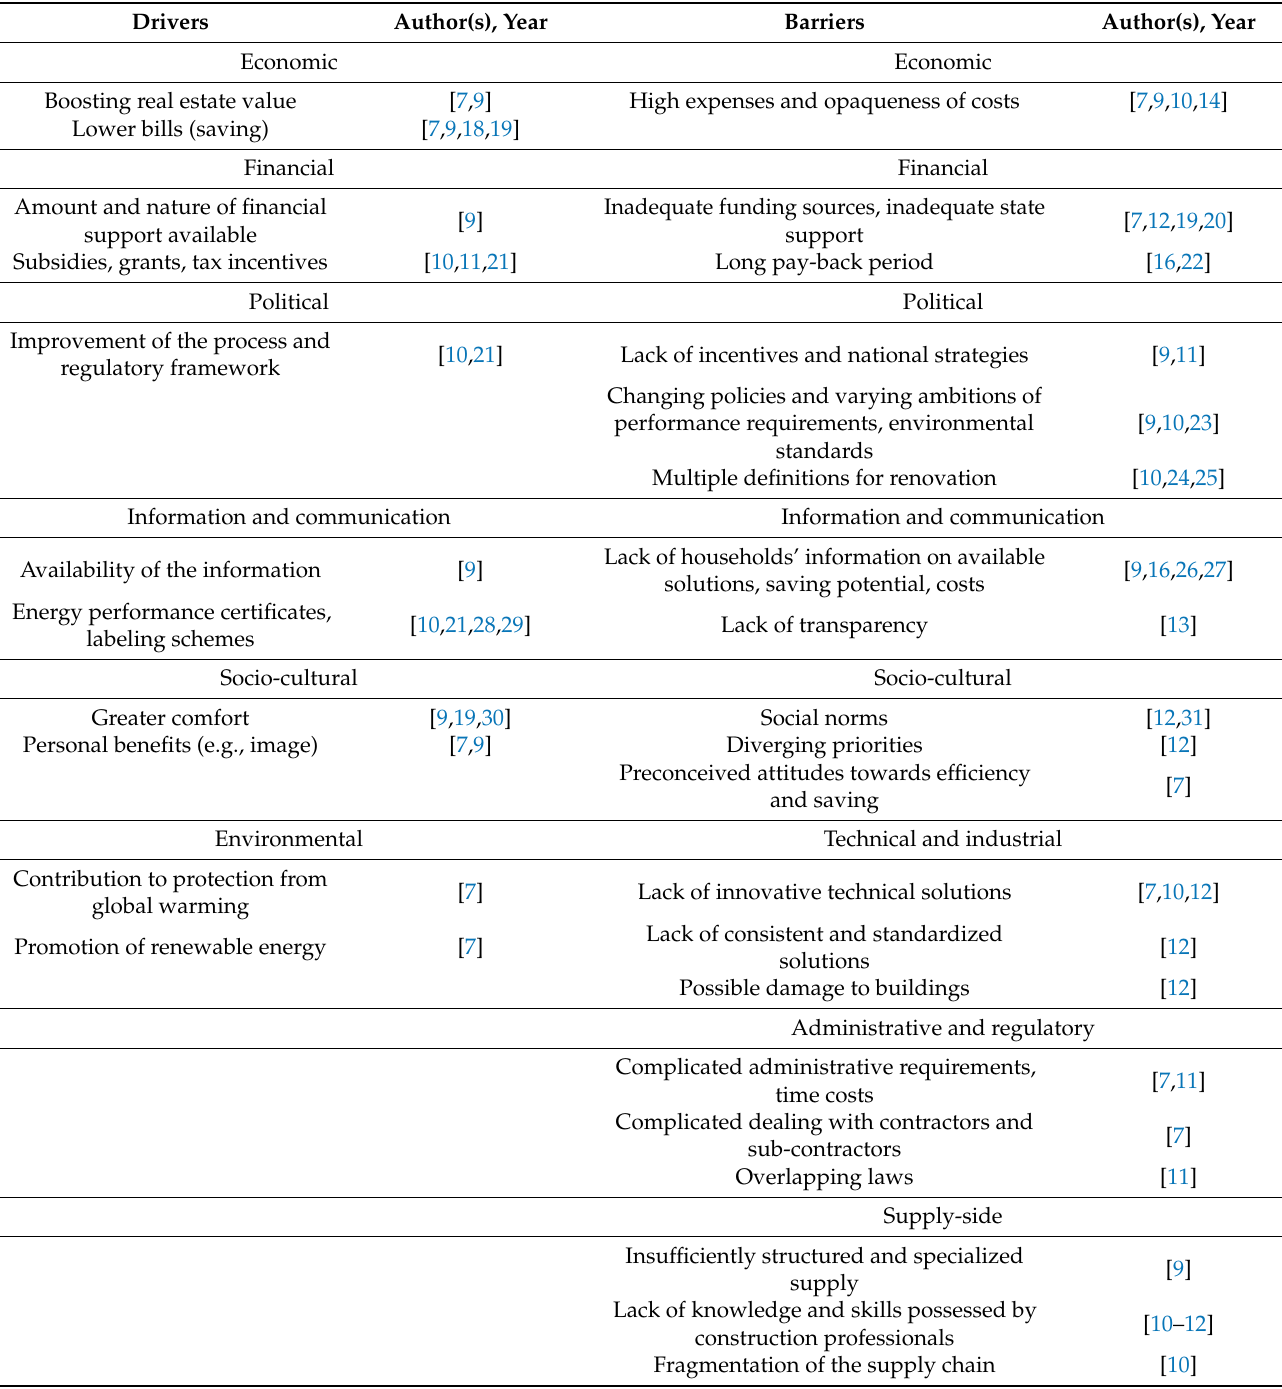
Table 1. Drivers and barriers to the energy-efficient renovation of buildings in the